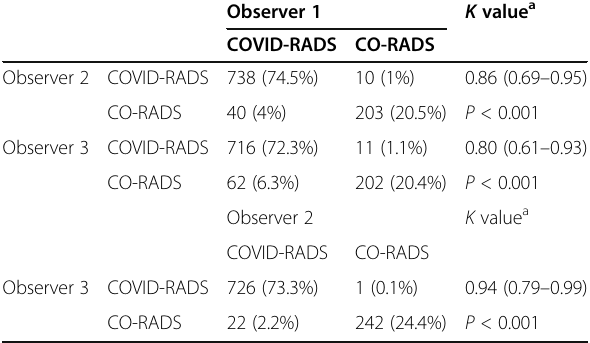
Table 4 Interobserver preference